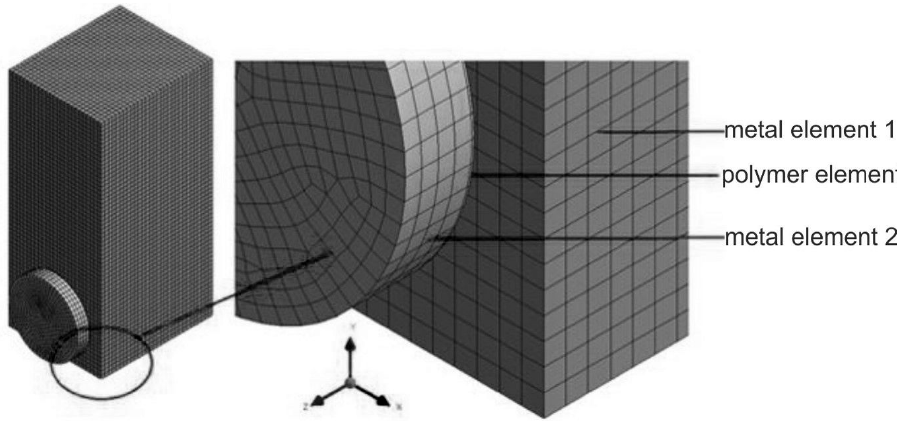
Figure 9. 3D model no. 2: specimen with an adhesively bonded cylindrical element.